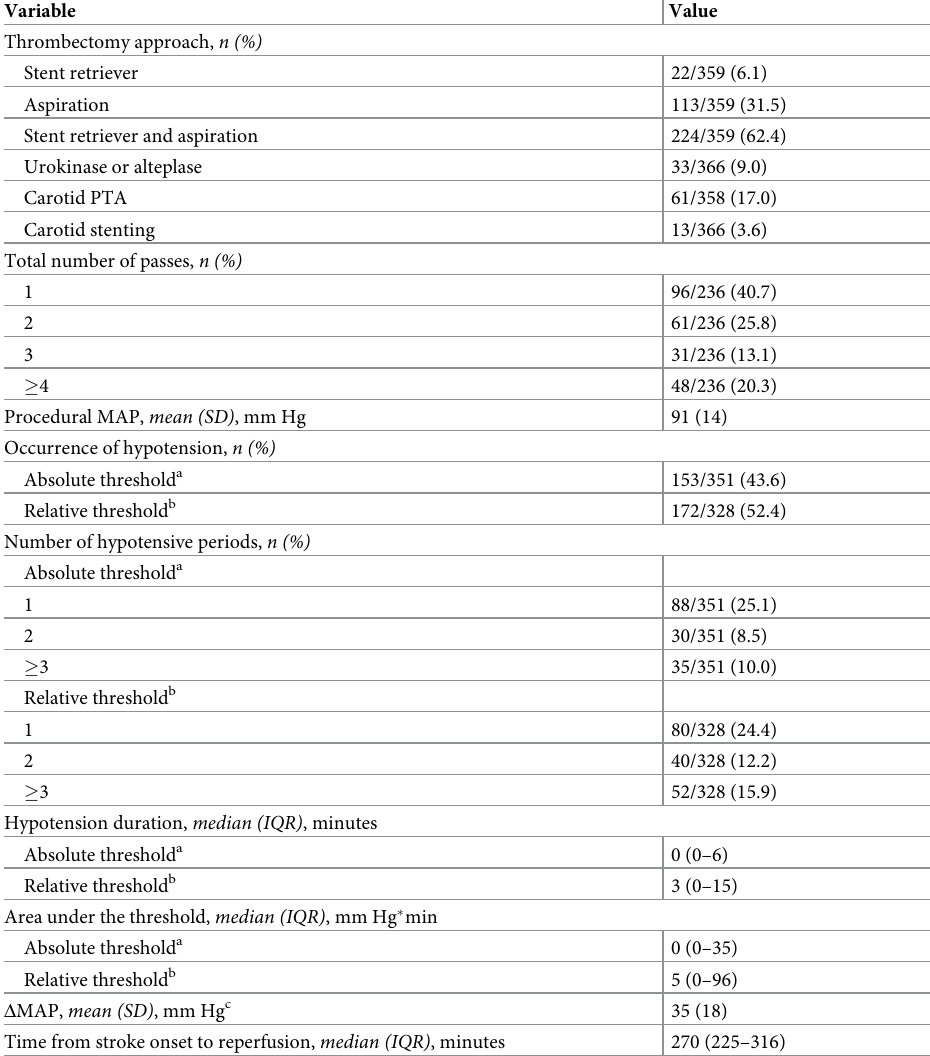
Table 2. Procedural